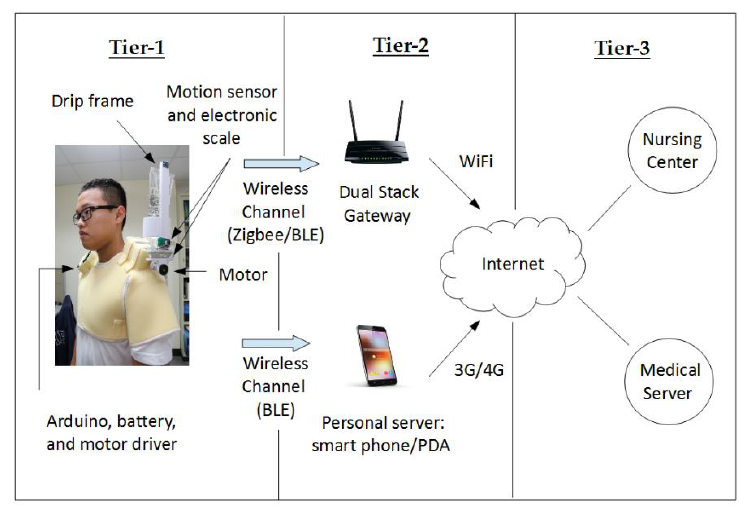
Figure 29. A three-tier communication architecture.